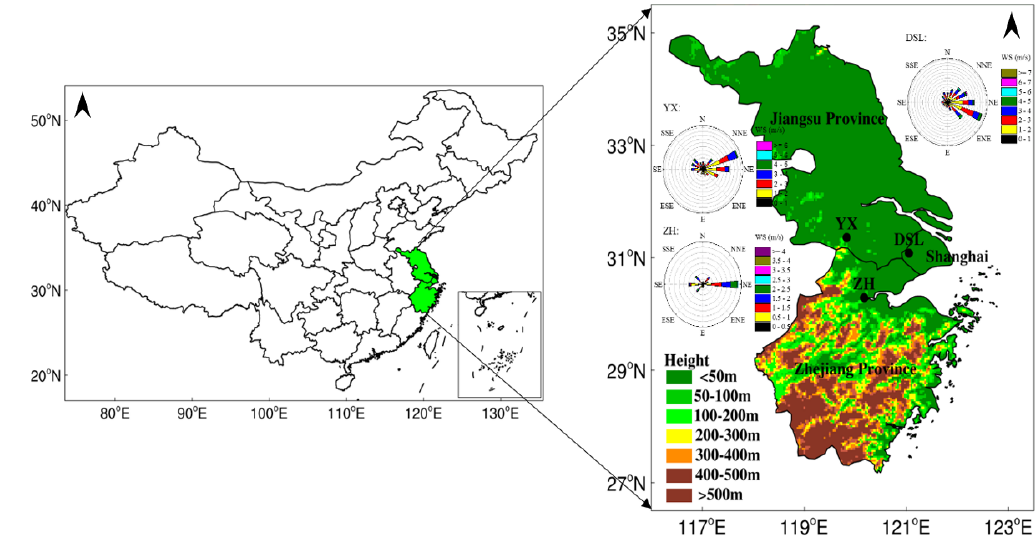
Figure 2. Location of urban Zhaohui supersite, Dianshan Lake regional supersite and urban Yixing station.